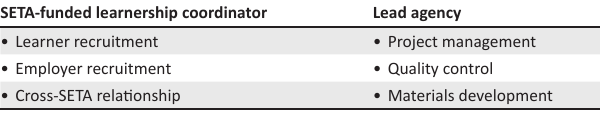
TABLE 1a: Responsibilities of different stakeholders in the learnership process.